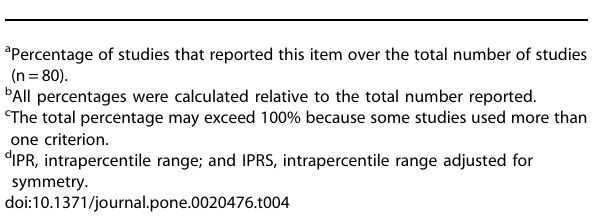
Table 4. Characteristics of the Delphi